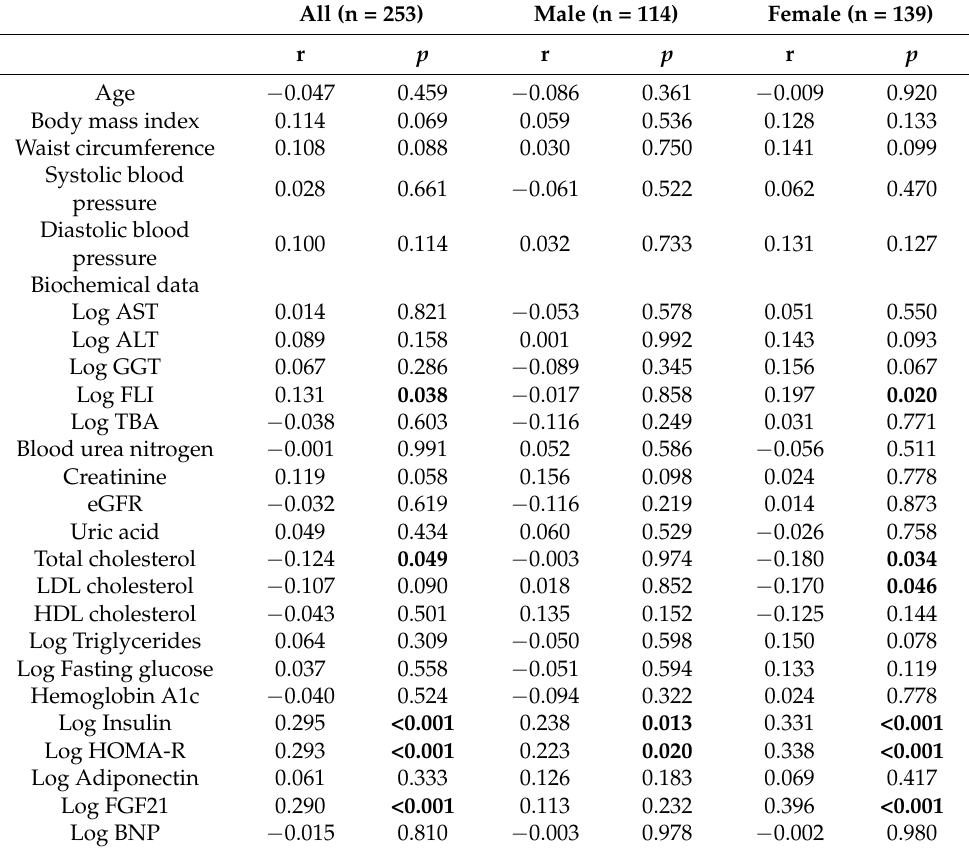
Table 2. Correlation analysis for Log Tsukushi (n = 253).